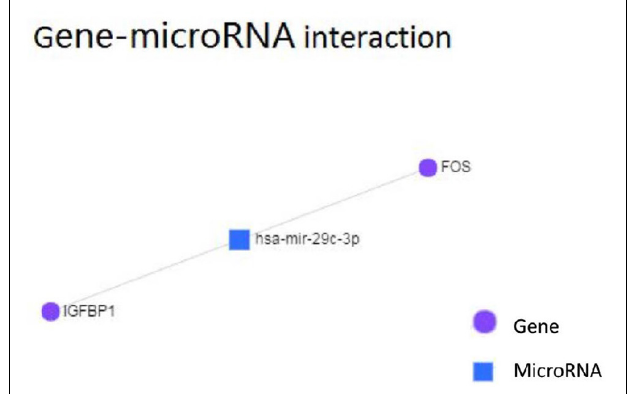
FIGURE 9 | Gene-microRNA interaction analysis of hinge